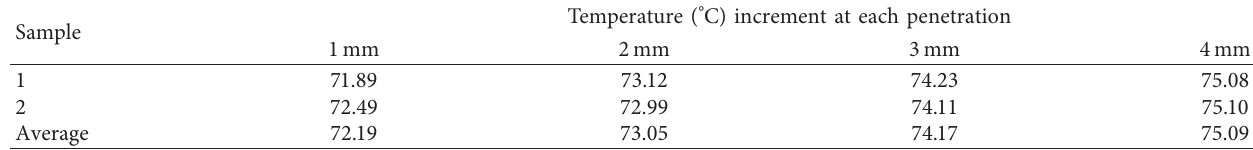
Table 4: Thermal properties of EVA via vicat apparatus.